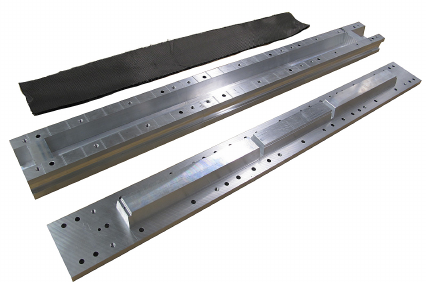
Figure 4. Casket molding (from the top): Carbon fiber sheets, heatable female mold and male mold.